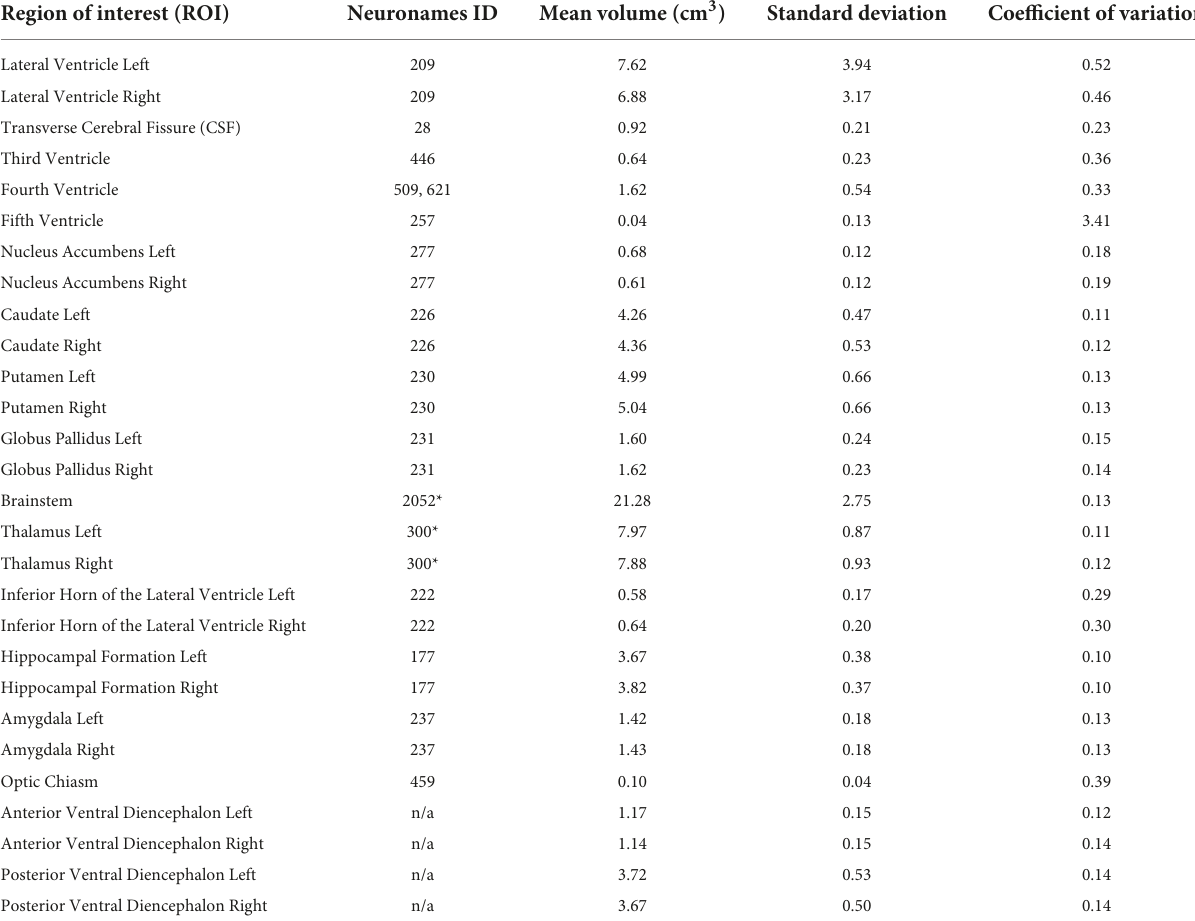
TABLE 1 Regional volumes from 50 young adult